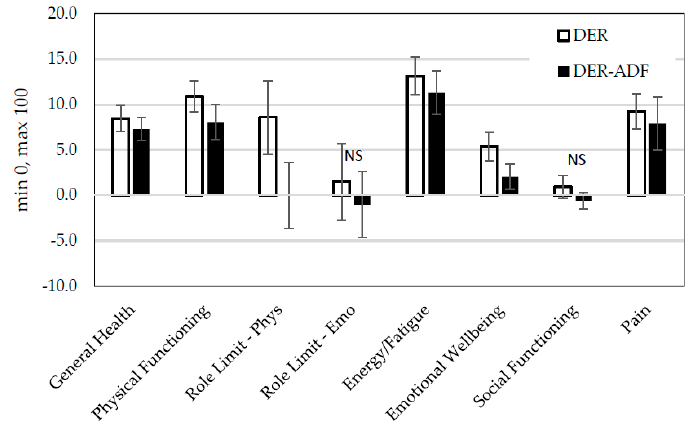
Figure 5. Changes in health-related quality of life scores (MOS SF36) between baseline and week 16 presented by treatment. DER, ( n = 68) standard meal replacement program; ADF + DER ( n = 67) modified meal replacement program; Phys, Physical; Emo, Emotional; NS, not significant. Note: Scores out of a possible 100 with higher scores representing improved health-related quality of life. For between-group differences, p > 0.05; for time effect improvements in general health, physical functioning, energy, emotional wellbeing, pain p < 0.0001; an interaction effect revealed an improvement in role limitations due to physical function only for the DER group ( p < 0.05), using linear mixed-effects model